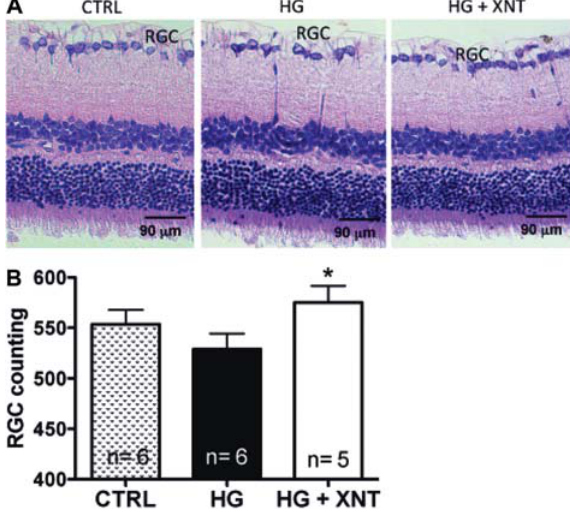
Figure 2. Histological analysis of retinal ganglion cells (RGC). A , Representative photomicrographs of retinas showing RGC in control (CTRL), hyperglycemic untreated (HG), and hyperglycemic XNT-treated (HG + XNT) animals. B , Quanti fi cation of RGC in retinas of rats. Note that the treatment with XNT prevented the loss of these cells in HG + XNT rats. *P o 0.05 compared to HG group (one-way ANOVA followed by the Newman-Keuls